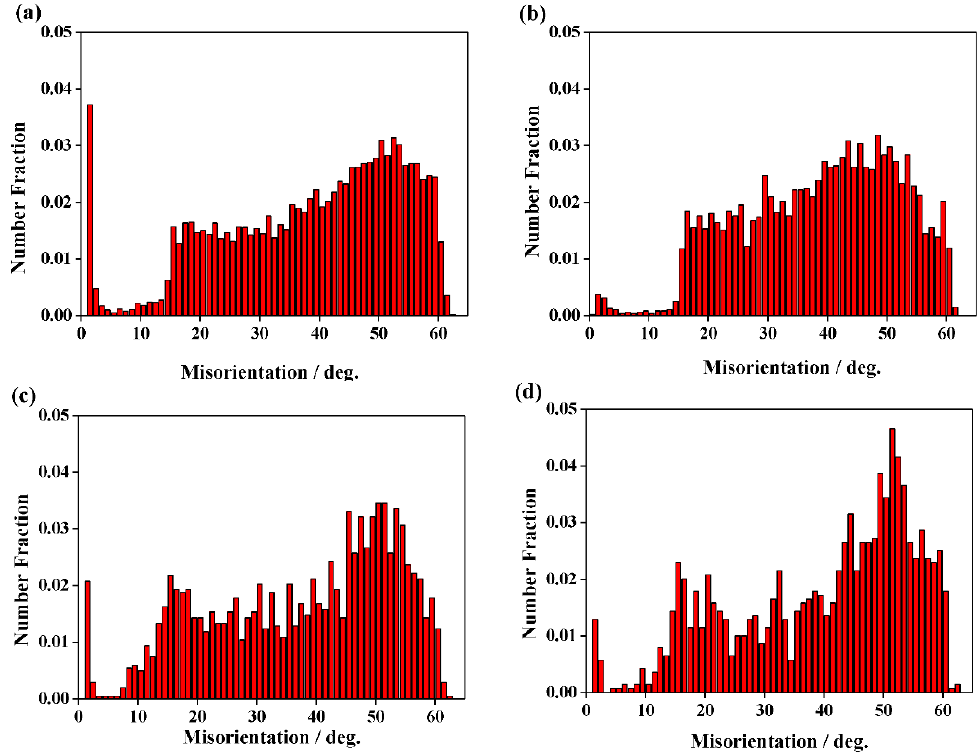
Figure 7. Histograms of the misorientation angles of ( a ) the ultrafine grains zone, ( b ) the transition zone, ( c ) the deformed zone after SMAT and ( d ) the initial microstructure before SMAT.